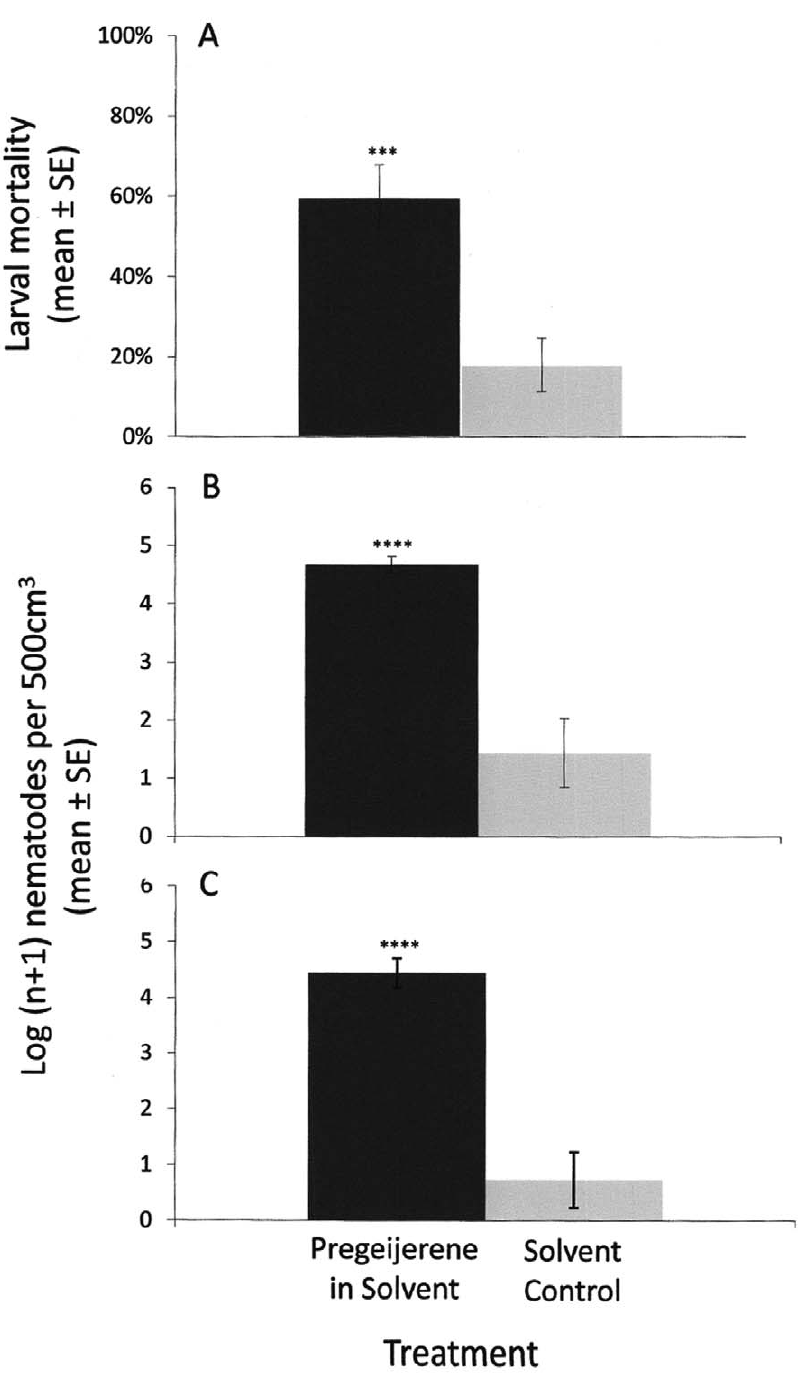
Figure 3. Effect of pregeijerene on mortality of Diaprepes abbreviatus larvae and associated attraction of entomopathogenic nematode infective juveniles (IJs) (all species combined). A) Average mortality of larvae buried with purified pregeijerene compared with the solvent control (N=10, t= 4.01, P=0.0008 ). B) Mean number of IJs recovered from cages containing purified pregeijerene compared with cages containing the solvent control (N=10, t= 5.33, P=0.00005 ). C) Mean number of IJs recovered from soil samples surrounding cages containing pregeijerene compared with the solvent control (N=10, t= 5.67, P=0.00003 ).